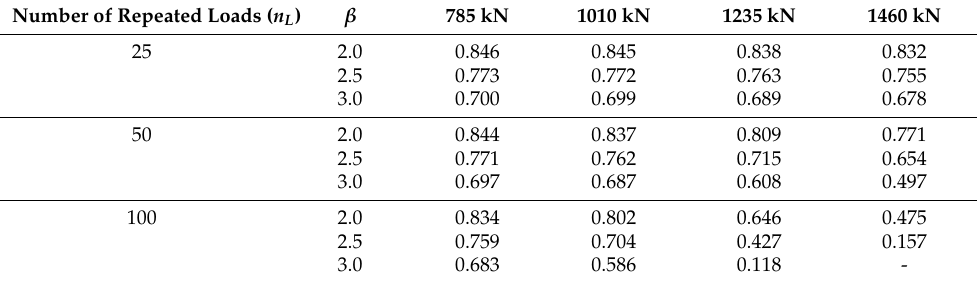
Table 24. Reduction factor for design residual shear strength ( φ r ). Number of Repeated Loads ( n L